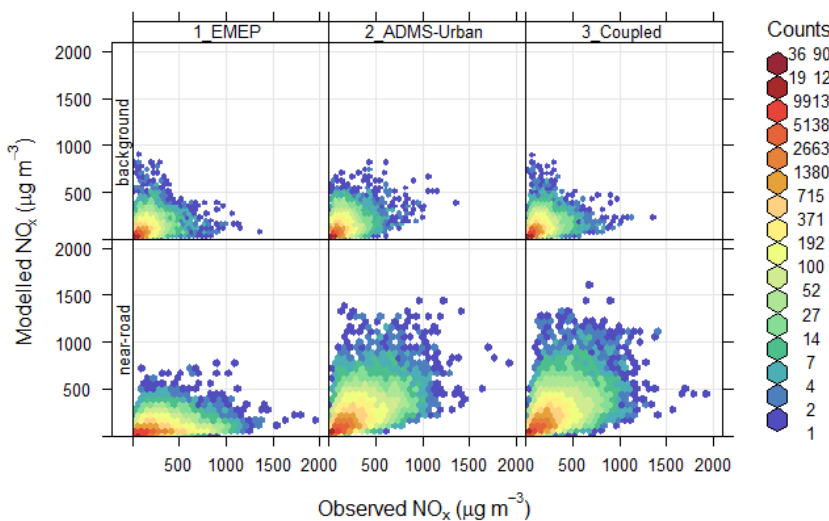
Figure 10. Frequency scatter plots for each model and site type showing the distributions of hourly average modelled and observed NO x concentrations (for sites where O 3 is also measured), where the colour represents the density of points for a given combination of measured and modelled values.